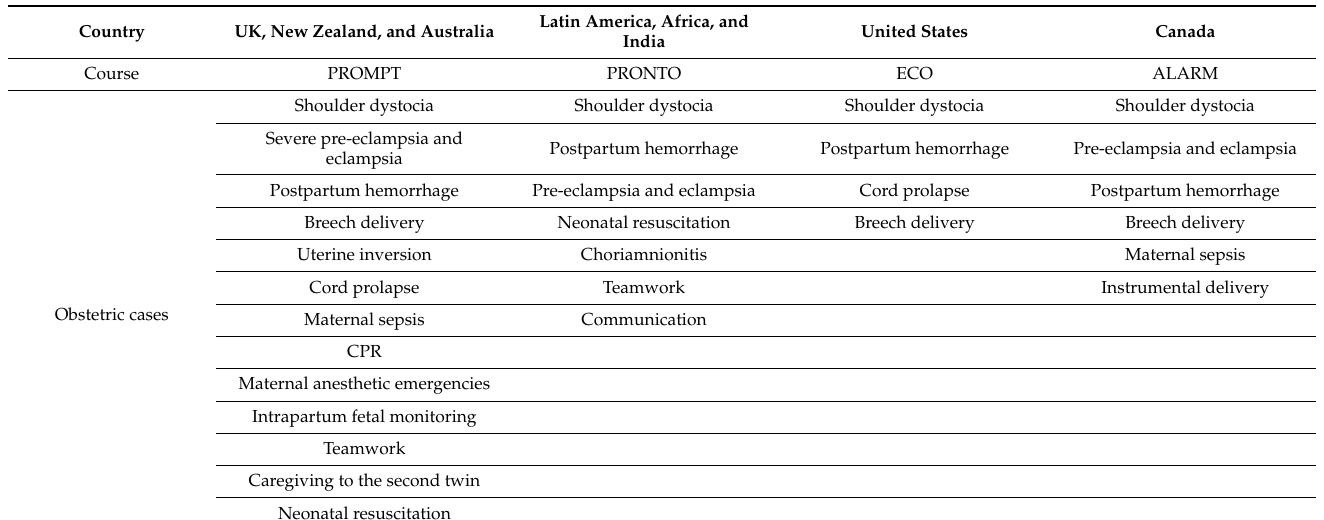
Table 3. Recommended cases for the simulation training of obstetric emergencies worldwide.